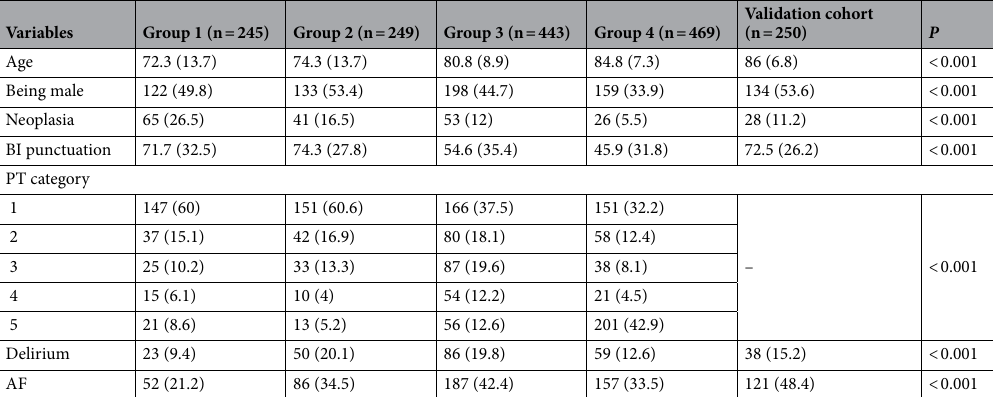
Table 1. Comparison among group of patients on the basis of enrollment site. Matosinhos (Group 1), Porto (Group 2), Aragon (Group 3) and Santiago de Compostela (Group 4). BI: Barthel index, PT: Pfeiffer´s test, AF: Atrial